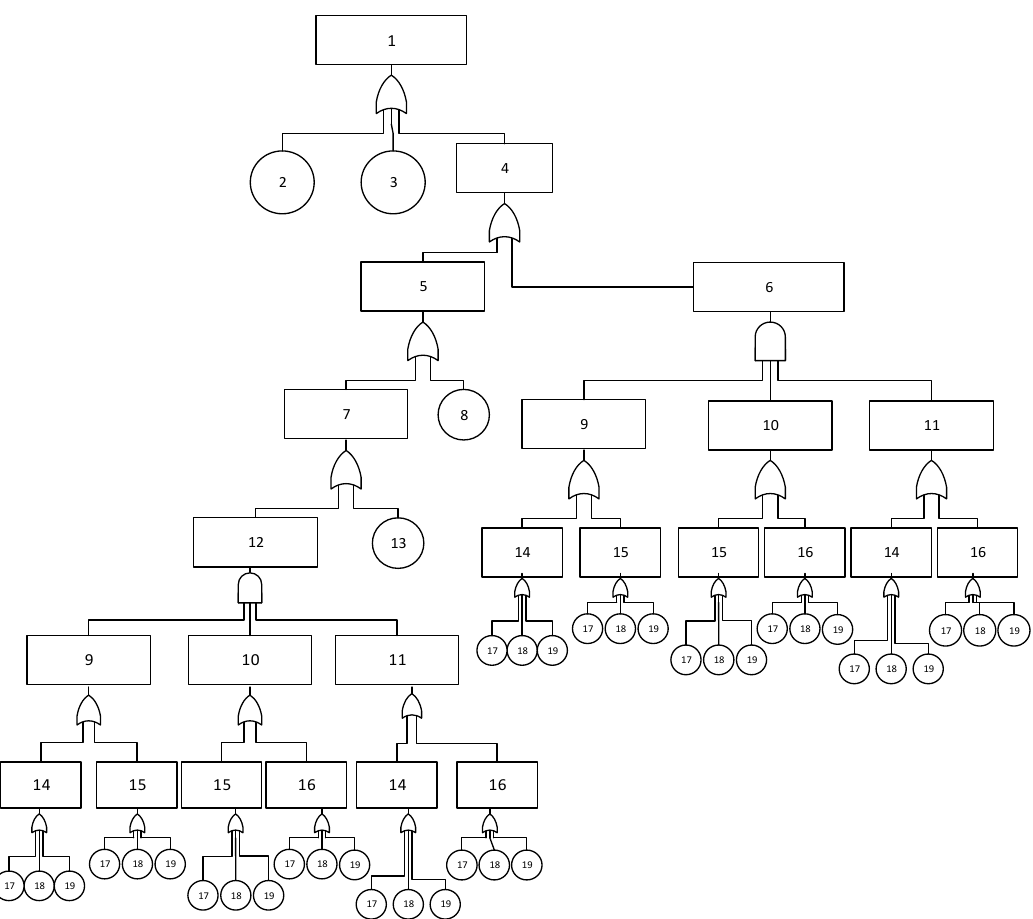
Figure A3. Fault tree of reactor scram failure activated by the outlet temperature signal of the primary heat exchanger. Note: 1 = reactor fail to scram. 2 = control rods insertion fail (B1). 3 = contact 6 system fail (B2). 4 = no signal. 5 = no scram manually. 6 = no scram from automatic system. 7 = the operator does not receive an alarm. 8 = operator fail (B7). 9 = detector system of JAA-01 CL 811 and 821 fail. 10 = detector system of JAA-01 CL 831 and 821 fail. 11 = detector system of JAA-01 CL 811 and 831 fail. 12 = detector system fail. 13 = alarm fail (B3). 14 = detector system of JAA-01 CL 811 fail. 15 = detector system of JAA-01 CL 821 fail. 16 = detector system of JAA-01 CL 831 fail. 17 = detector fail (B4). 18 = transmitter fail (B5). 19 = buffer fail (B6).